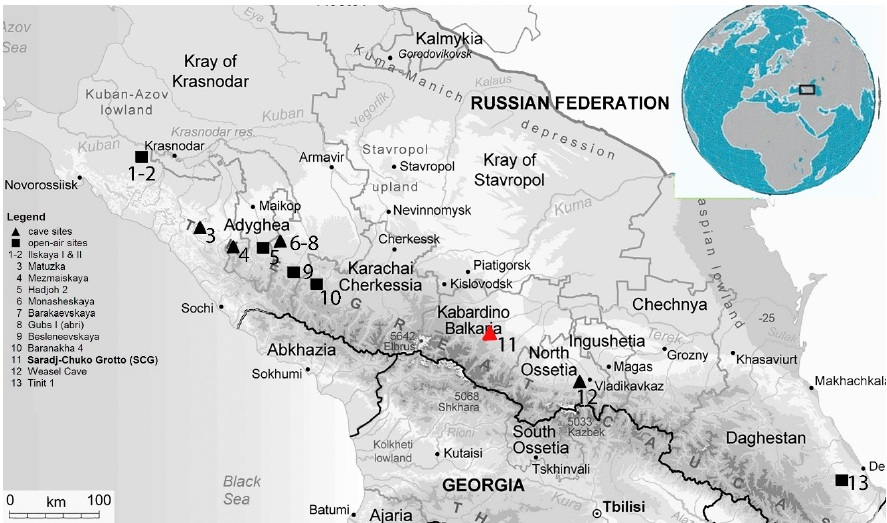
Figure 1. The important stratified Middle Paleolithic sites in the Northern Caucasus, Russia.